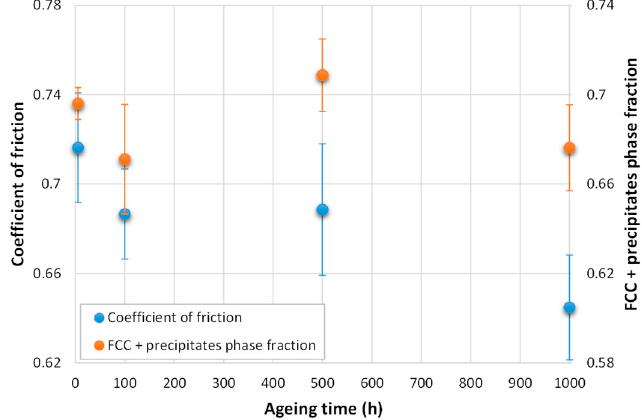
Figure 8. Coefficient of friction throughout the wear test on as-cast AlCoCrFeNi 2.1 and after aging at 800 °C at three different durations.